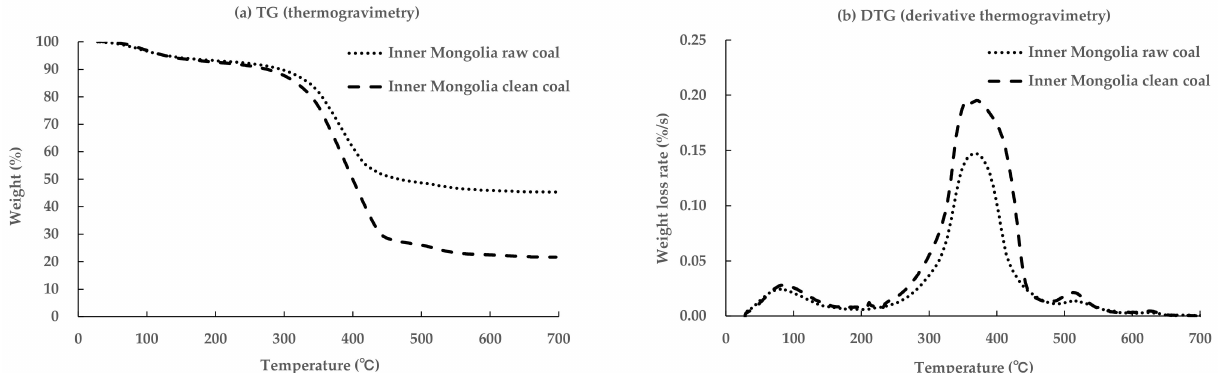
Figure 5. TG-DTA comparison of raw coal and filtered clean coal. ( a ): TG (thermogravimetry); ( b ): DTG (derivative